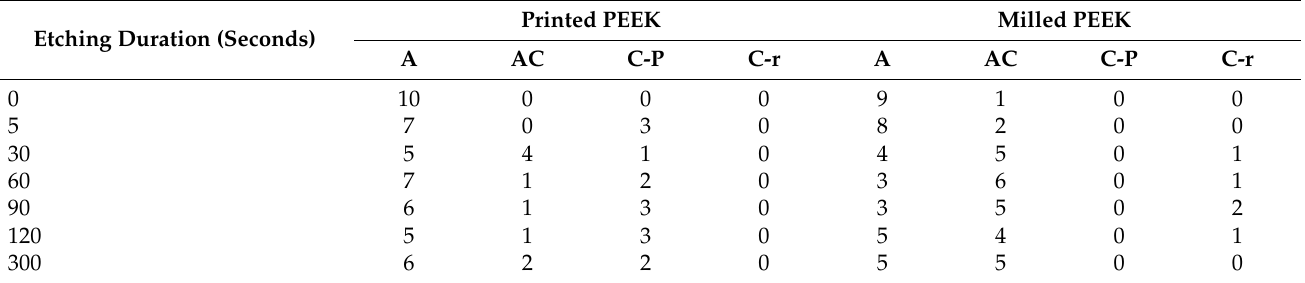
Table 4. Failure modes of each testing group after different surface treatments.